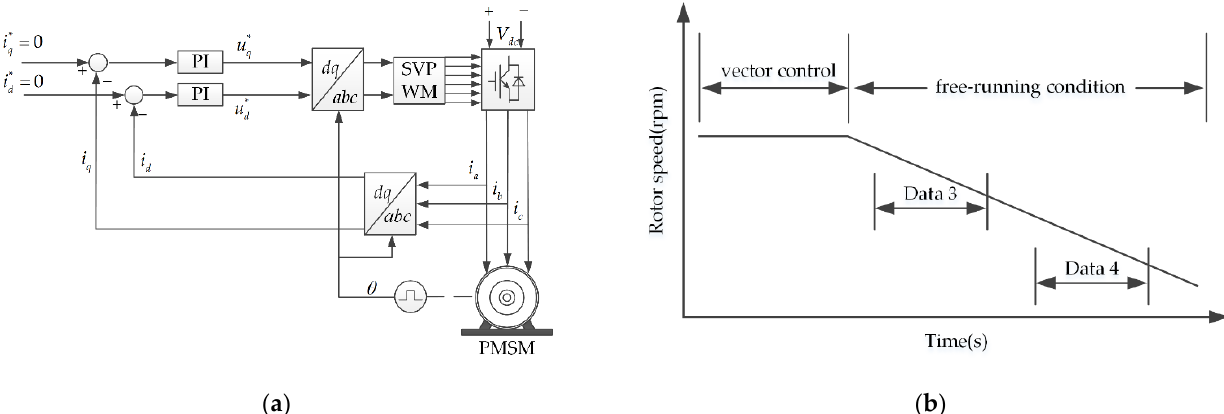
Figure 2. Proposed method under free-running condition. ( a ) Current control diagram; ( b ) process of data measurement.